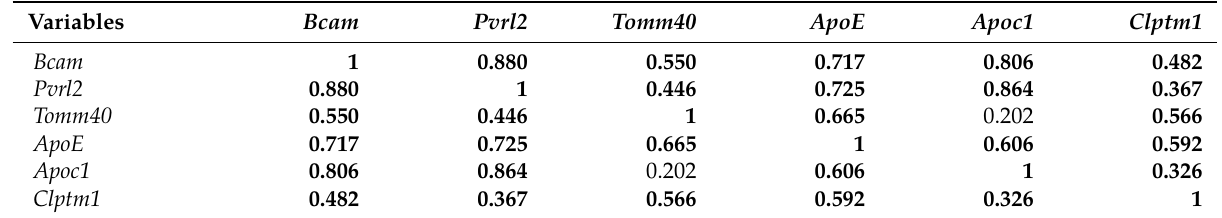
Values in bold are different from 0 with a significance level alpha =